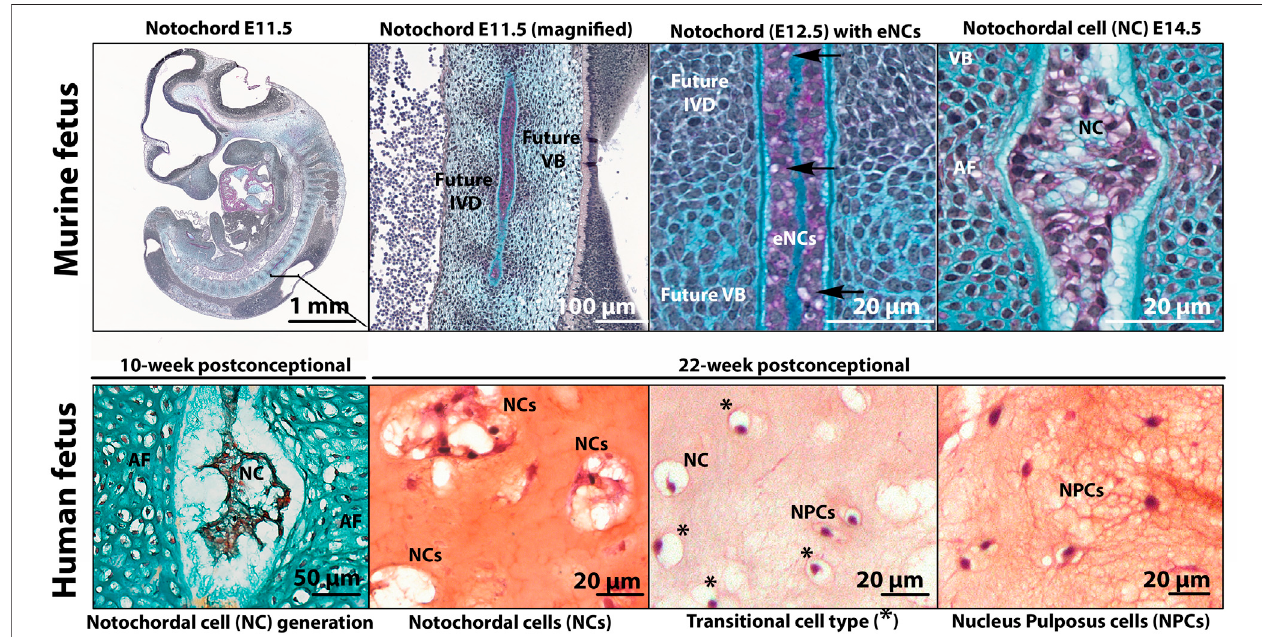
FIGURE 3 | Histologic images to exemplify the terminology of embryonic notochord cells (eNCs), vacuolated notochordal cells (NCs), non-vacuolated nucleus pulposus cells (NPCs), and cells with a transitional phenotype (with some small vacuoles remaining). In E11.5 and E12.5 murine fetuses, the notochord is a rod-like structure with tightly packed small non-vacuolated eNCs con fi ned by the basement membrane sheath (Alcian Blue). In mice, the appearance of small intracytoplasmic vacuoles (arrow) are an indication of eNC into NC transition observed from E12.5. By E14.5, the regression of the notochord is almost complete and the intervertebral discand vertebral bodies are being formed (Alcian Blue). At this stage, NCs exhibit large intracytoplasmic vacuoles. In contrast, a 10-week postconceptional human fetus (Safranin O/Alcian Blue), the notochord is pinching into NP tissue containing NCs, and the rest of the IVD (annulus fi brosus (AF) and vertebras) are being formed. The human NC, transitional cell type, and NPC (Safranin O/Fast Green) pictures were obtained from a 22-week postconceptional human fetus.HumanNCgenerationimagebycourtesyofWilsonChanandVivianTam;murineimagesbycourtesyofMaevaDutilleul.E,embryonicday;IVD,intervertebraldisc; VB, vertebral